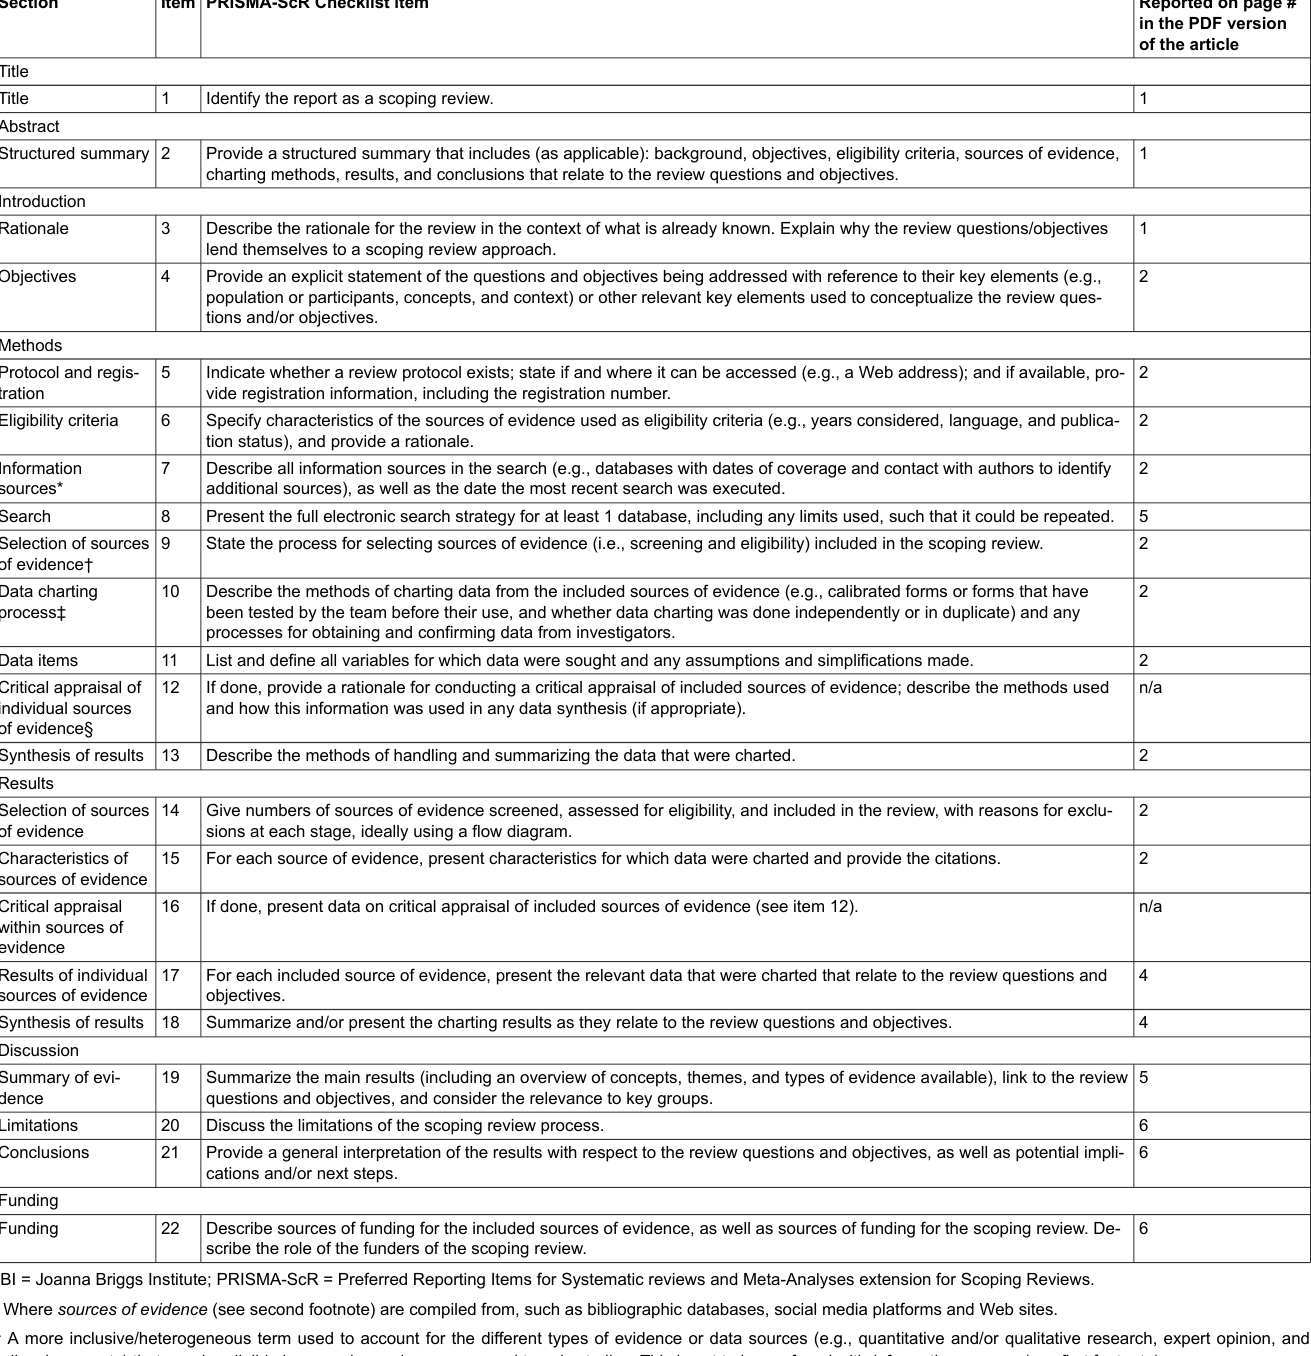
Table S1: Preferred Reporting Items for Systematic reviews and Meta-Analyses extension for Scoping Reviews (PRISMA-ScR)